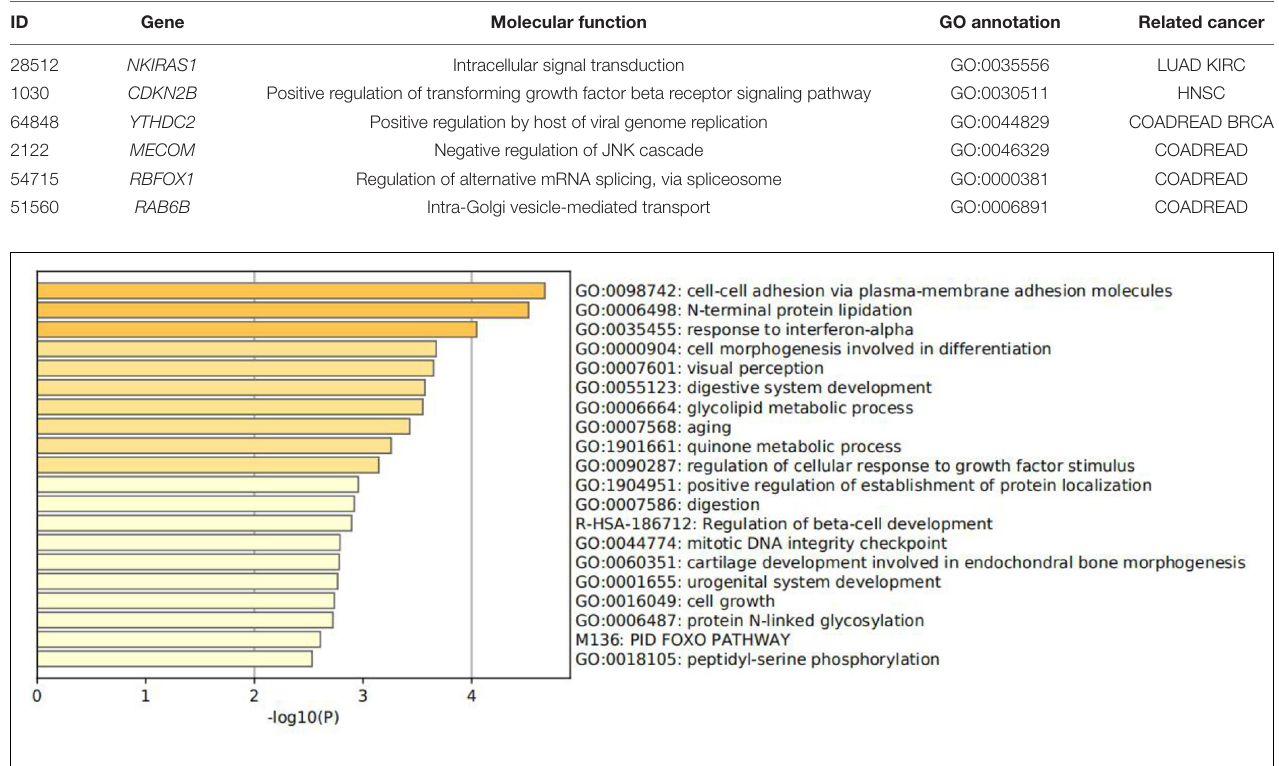
FIGURE 6 | Enriched terms bar graph colored by p -values in gene